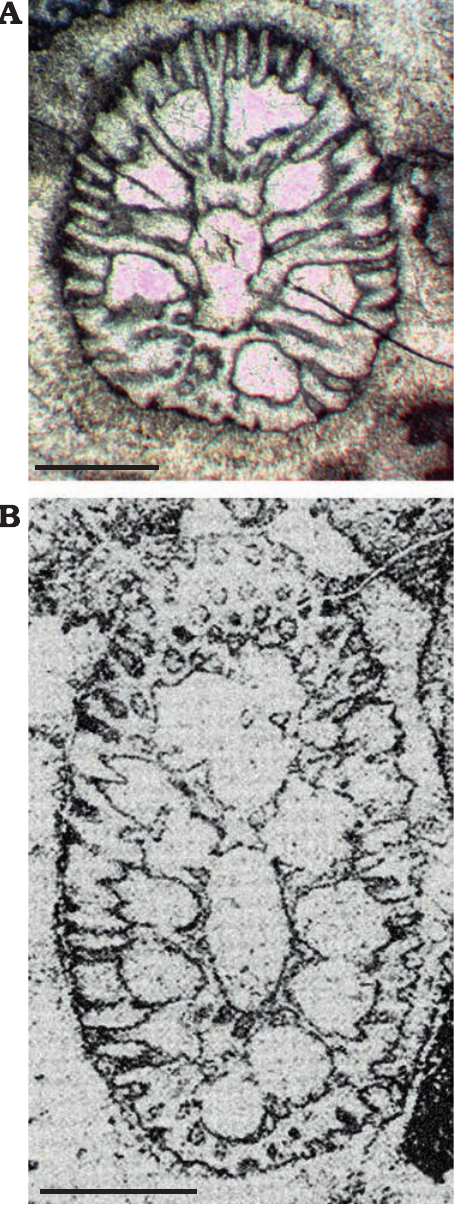
Fig. 11. The structure of the Late Triassic species of dasycladalean algae Distefanopolia gen. nov. A . Distefanopolia micropora (Di Stefano, 1981 ex Di Stefano and Senowbari-Daryan, 1985) nov. comb., MGG-PA/Si24ax, Norian, Cozzo di Lupo (Palermo, Sicily), oblique section; note the first fertile whorl (bottom) showing two tufts of about eight pores, the third pore aside displays the usual inflated shape. B . Distefanopolia carpatica (Bystrický, 1967) nov. comb., Norian, Muráň-PIateau (Gemer, Slovakia), oblique section, holotype, corresponding to Bistricky (1967: pl. 15: 3, thin section Nr. 2237), note the large, rounded gametophore encircled by several secondary laterals (below). Scale bars 1 mm.